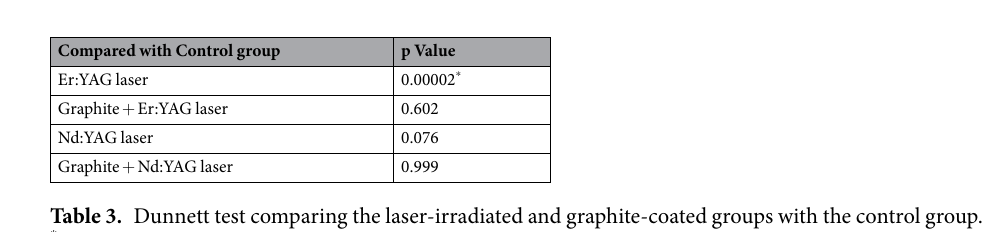
Table 3. Dunnett test comparing the laser-irradiated and graphite-coated groups with the control group. * Significantly different (p <